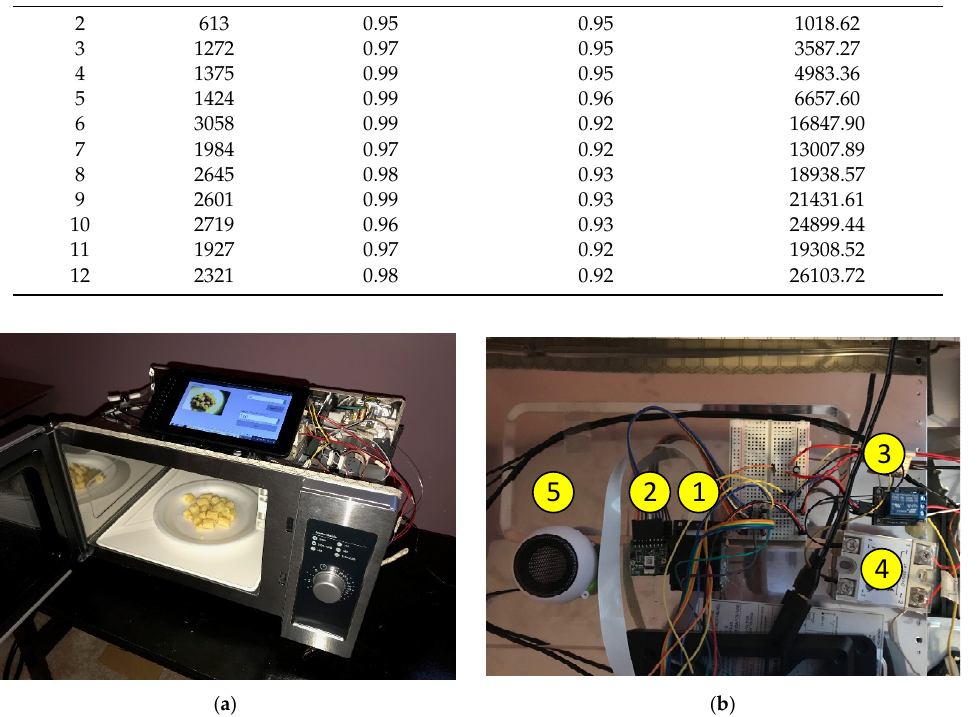
Figure 8. Photograph of the prototype hardware: ( a ) embedded system interfaced with a commercial microwave oven. The Raspberry Pi microcontroller is attached at the backside of the display unit; ( b ) top view of the oven showing the hardware components: (1) RPi HD camera; (2) FLIR thermal camera; (3) Relay (4) SSR; (5) Speaker;.